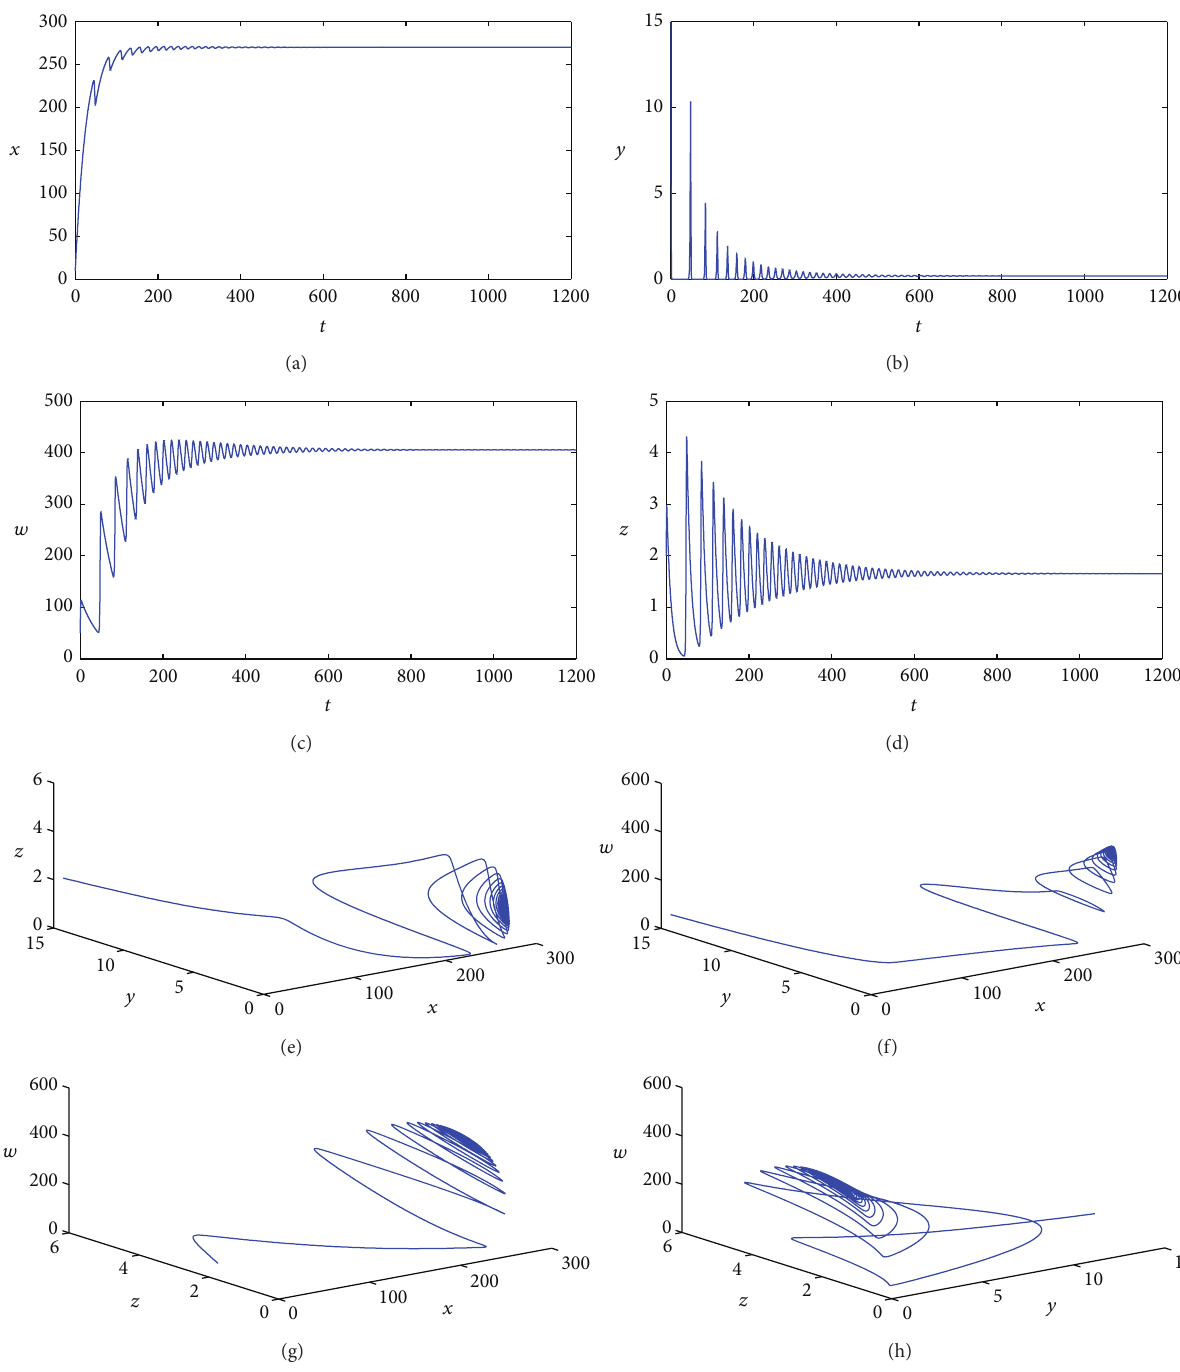
𝜖 = 0.9 , 𝜂 = 0.9 , and time delay 𝜏 = 15 ), is shown in Figure 4. According to Theorem 4, the parameters 𝐶 1 = −2.1108𝑒+004+1.1224𝑒+005𝑖 , 𝜆 󸀠 = −12.1371−0.6438𝑖 , 𝜇